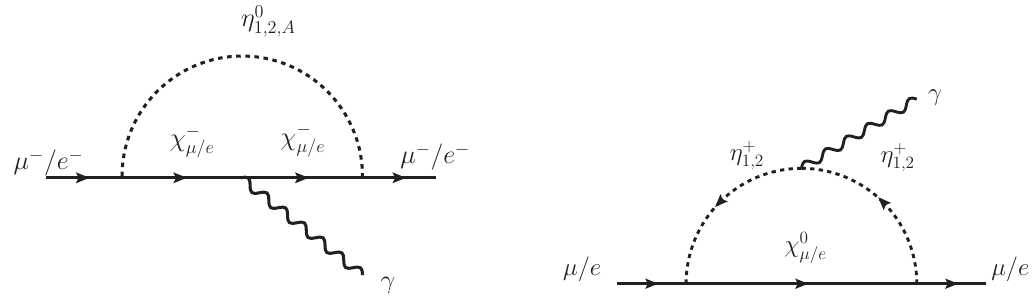
Figure 1 . Feynman diagrams for the muon/electron g g 2 in the model with Y D = 1 ( Y D = (cid:0)